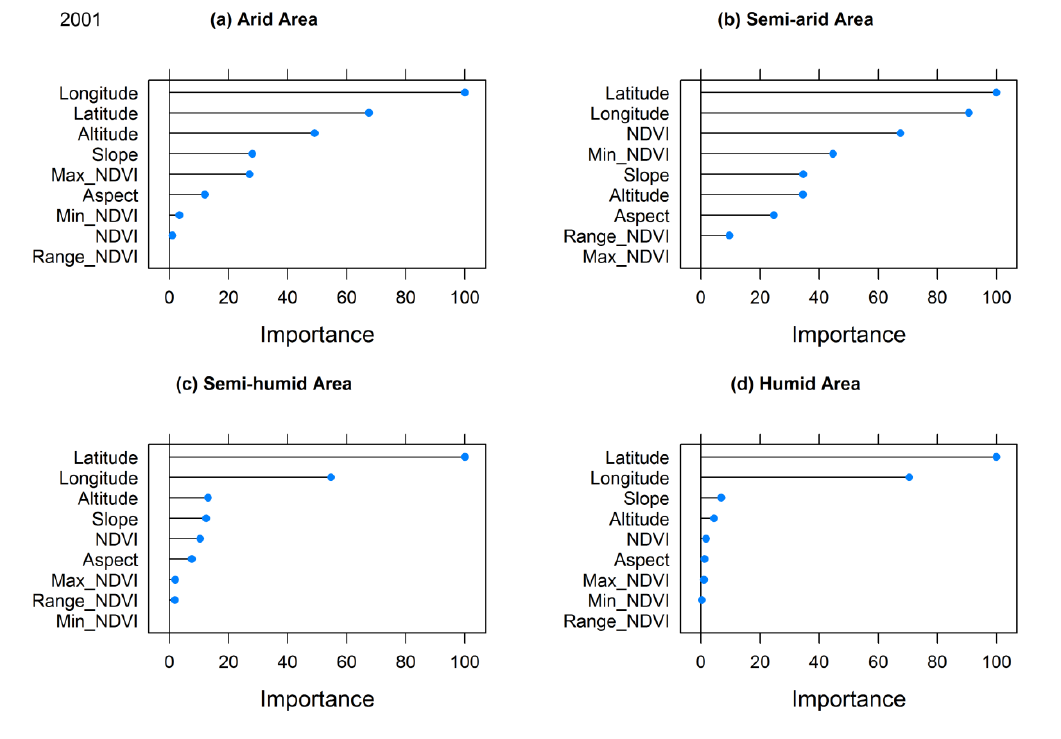
Figure 5. Scatter plot of the measured annual precipitation from 596 meteorology stations versus the predicted precipitation derived from ( a ) the multiple linear; ( b ) exponential; ( c ) Random Forest regression model, and ( d ) original TRMM 3B43 for the years of 2001 and 2010 over Mainland China,